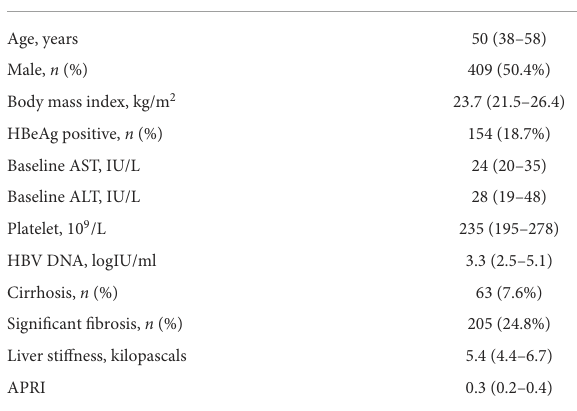
TABLE 1 Patient characteristics according to treatment